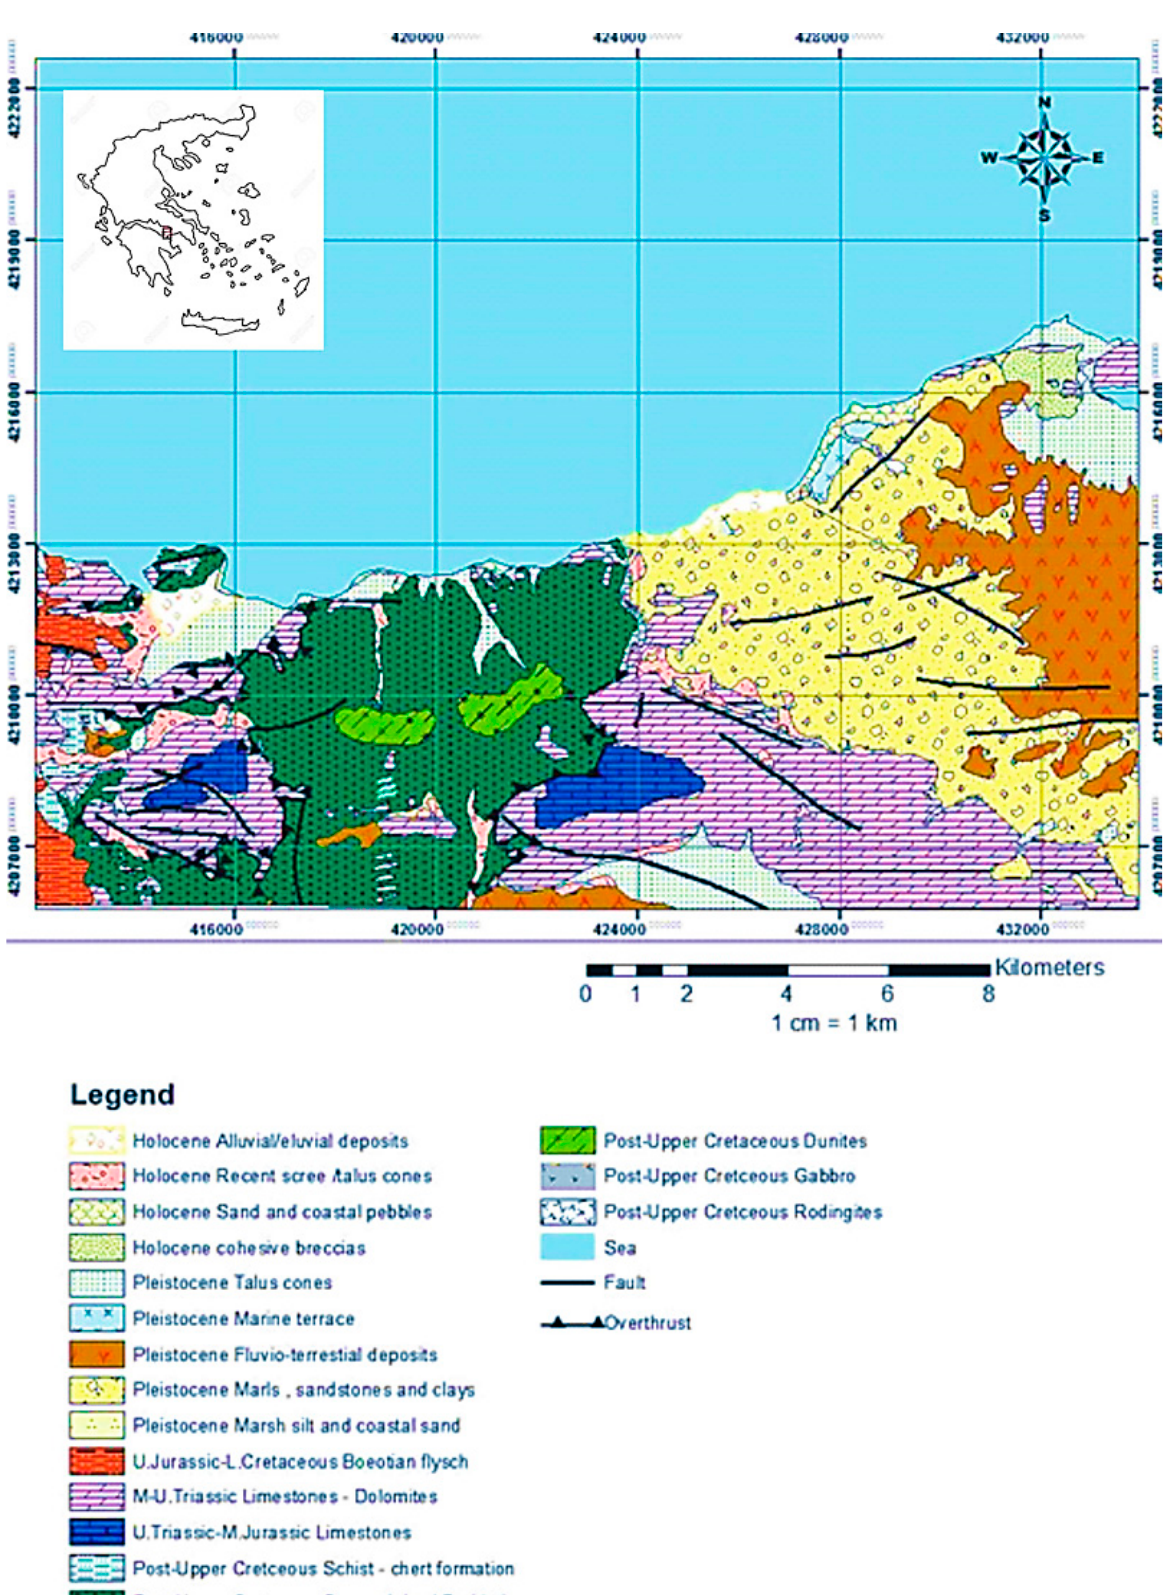
Figure 2. Geological map of the Kapareli sheet IGME [58] (modified after fieldwork and mapping by using ArcMap 10.1); the black rectangle in the inset shows the study area.